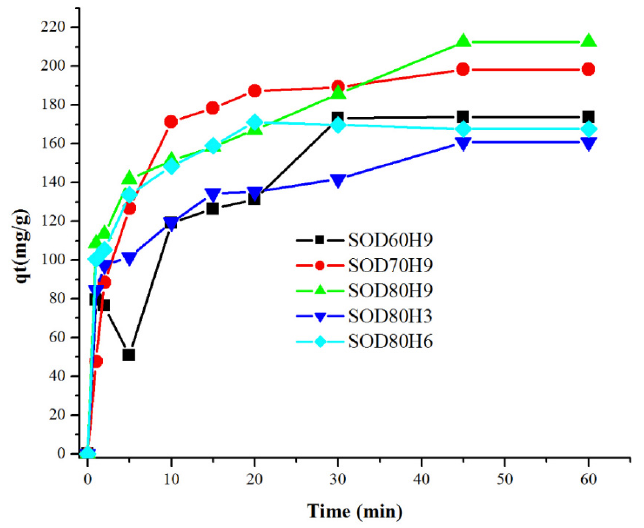
Figure 8. Pb 2+ adsorption on SOD samples with CTABr (Co = 100 ppm, V = 0.2 L, W = 0.05 g). Adsorption of metal cation on sodalite occurs on the surface between the positive charge metal cation and the opposing charge zeolite surface [40]. Pb 2+ can occupy the sodalite surface via interaction with Si-O- by displacing the hydrogen in Si-OH (Equations (5)–(7)). Apart from that, Pb 2+ can also adsorb on sodalite via the cation-exchange process. The cation exchange occurred between Na + ions in the sodalite framework and Pb 2+ ions (Equation (8)). The mechanism for the exchange of Na + ions with Pb 2+ ions is shown through the following equations: